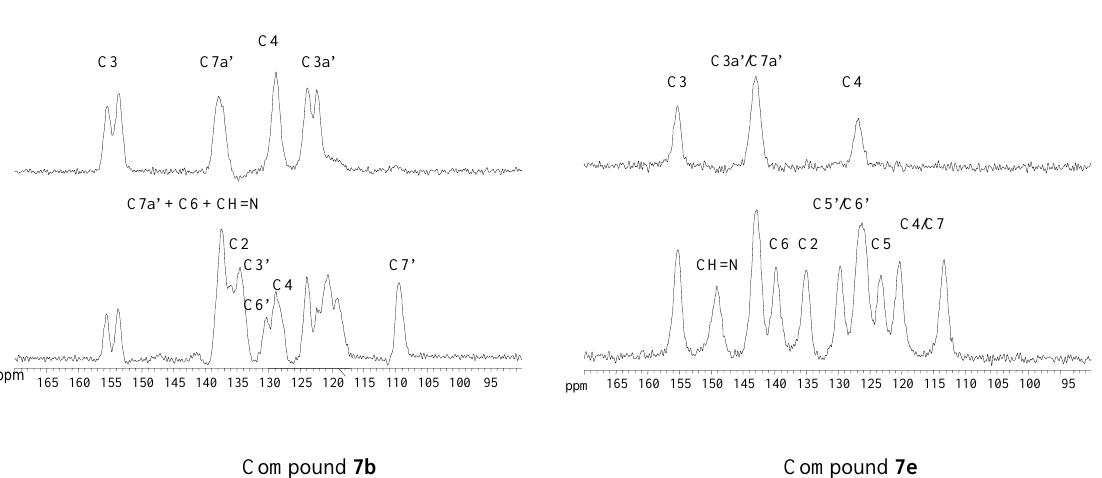
Figure 6 . 13 C-CPMAS NMR spectra of compounds 7b and 7e